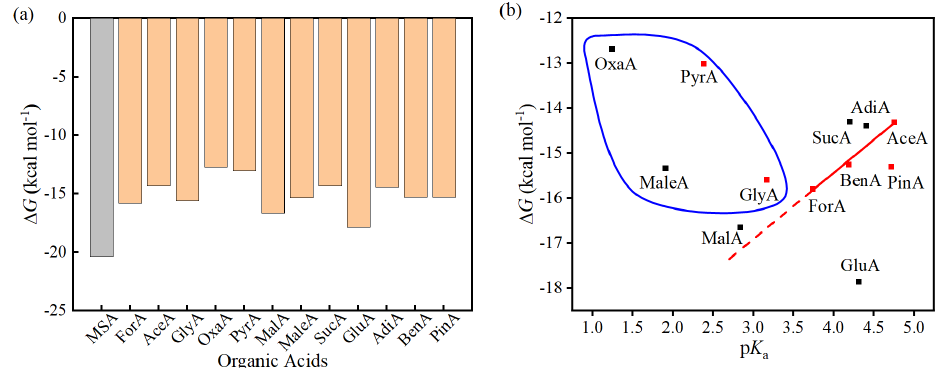
Figure 2. Binding free energy ( (cid:49)G ) (kcalmol − 1 ) of the 12 (MSA) 1 (MA) 1 (OA) 1 clusters and the (MSA) 2 (MA) 1 cluster at the DLPNO- CCSD(T)/aug-cc-pVTZ// ω B97X-D/6-31 ++ G(d , p) level of theory (the calculations are performed at 298.15K and 1atm) (a) and the rela- tionship between the p K a of the organic acids with the binding free energy ( (cid:49)G ) (kcalmol − 1 ) of the 12 (MSA) 1 (MA) 1 (OA) 1 clusters at the DLPNO-CCSD(T)/aug-cc-pVTZ// ω B97X-D/6-31 ++ G(d , p) level of theory (the calculations are performed at 298.15K and 1atm) (b) . The solid line in (b) is the fitted linear regression line of the (cid:49)G on p K a value for the simplest monocarboxylic acids with r = 0 . 996, and the dashed line is the extension of the solid line. The red squares represent monocarboxylic acids, the black squares represent dicarboxylic acids, and the circled species contain intramolecular H